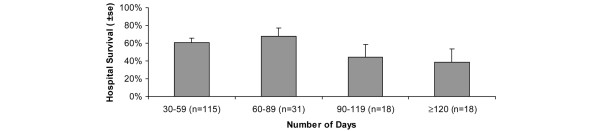
Hospital survival by number of ICU days. ICU, intensive care unit; se, standard error.